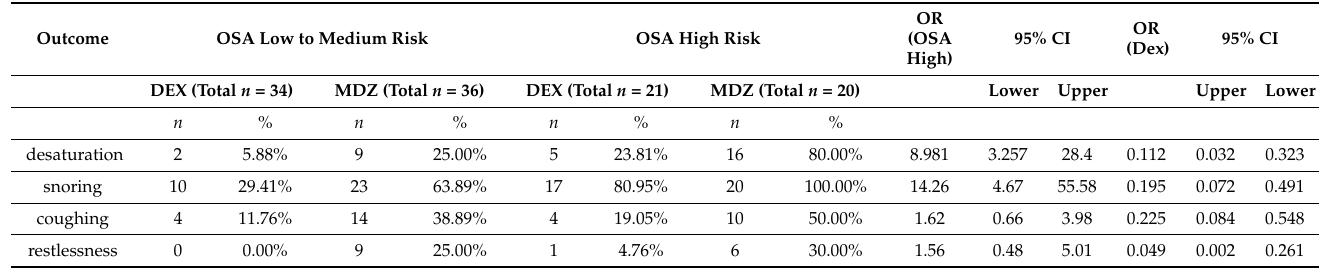
Table 2. Intraoperative